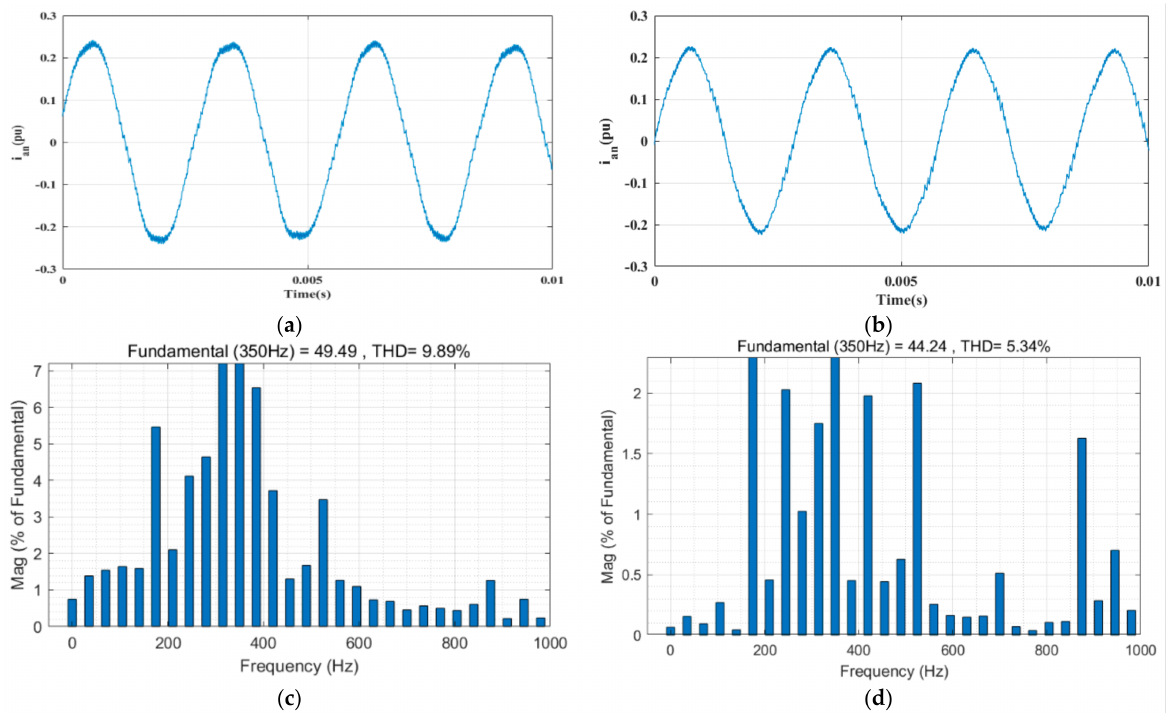
Figure 13. A–phase current waveform and THD value before and after adding voltage instruction compensation algorithm. ( a ) adding pre–phase current waveform. ( b ) adding post–phase